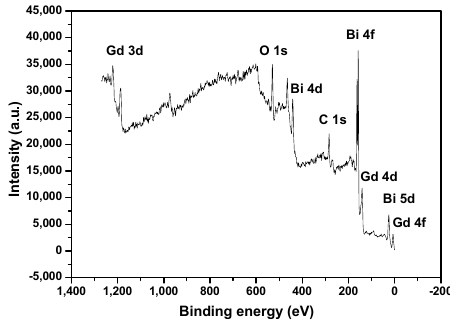
Figure 3. XPS spectrum of BiGdO 3 .